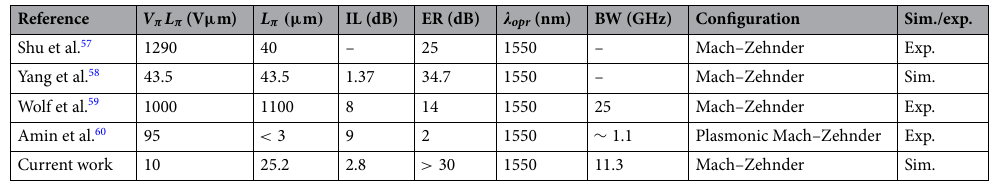
Table 1. Comparison of characteristics in related